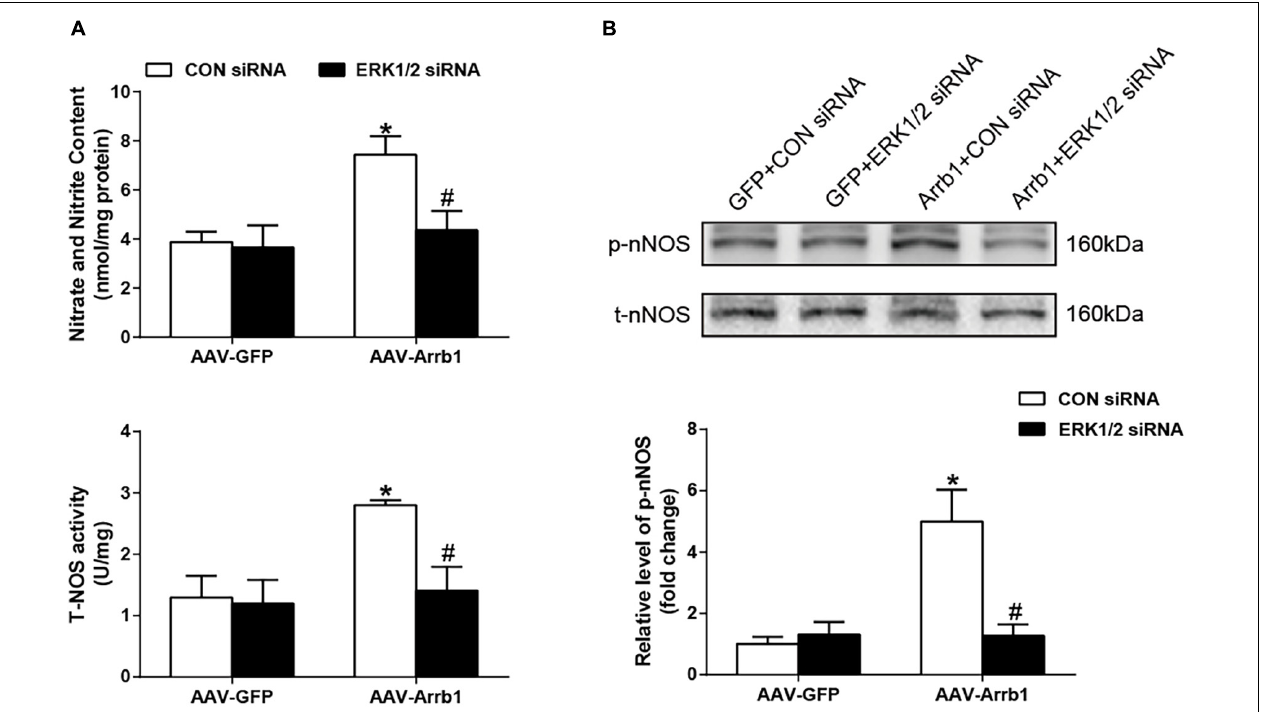
FIGURE 5 | Effects of knockdown of ERK1/2 in the RVLM on the β -arrestin1-induced NO production and nNOS phosphorylation. (A) Relative changes of nitrate and nitrite content (top) as well as total NOS activity (bottom) in the RVLM among the four groups. (B) Representative gel bands (top) and quantification data (bottom) of changes in phosphorylated nNOS after treatment of ERK1/2 siRNA in the RVLM among the four groups. n = 5 per group, * P < 0.05 vs. AAV-GFP; # P < 0.05 vs. CON siRNA. Relative level, standardization of dividing phosphorylated values by total values. ERK1/2, extracellular regulated kinase; RVLM, rostral ventrolateral medulla; NO, nitric oxide; nNOS, neuronal nitric oxide synthase; NOS, nitric oxide synthase; siRNA, small interfering